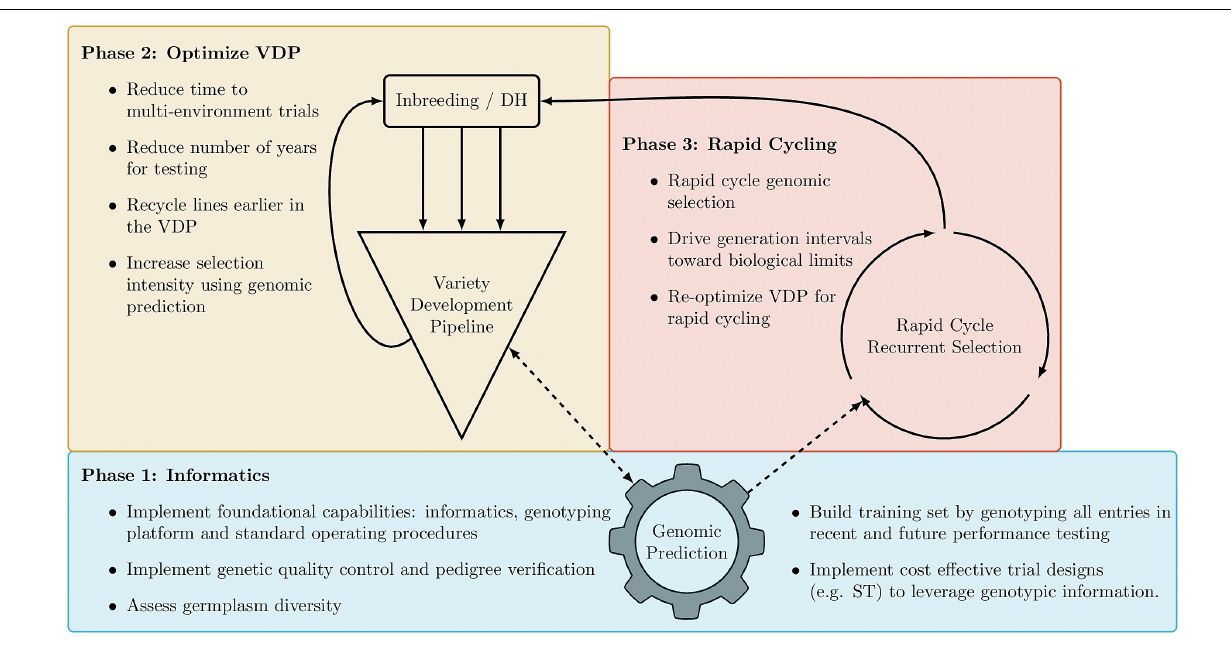
FIGURE 5 | Recommended implementation of genomic information into a breeding program. Phase 1 (blue) , Phase 2 (yellow) , and Phase 3 (red) . Solid lines indicate the flow of genetic materials, while dashed lines indicate the flow of